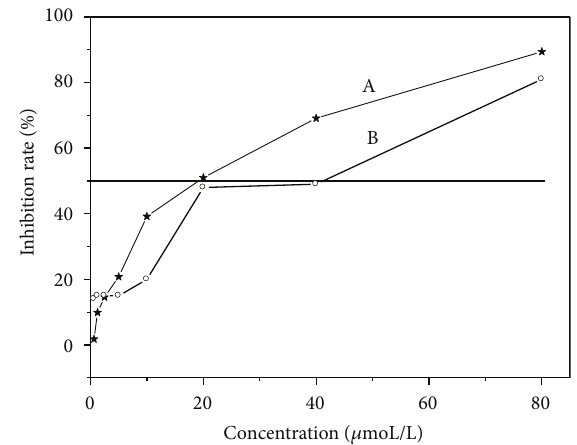
Figure 3: Inhibition rate of title complex (A) and AsI 3 (B) on the growth of the HL-60 cells in the culture medium with different con- centrations of AsI 3 [OOCCH 2 CH(NH 2 )CO] 2.5 ⋅ 2.5H 2 O and AsI 3 .